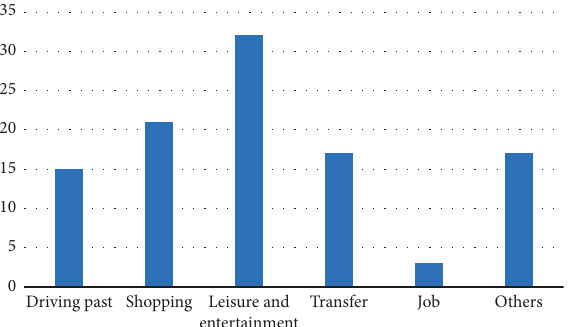
Figure 8: Thedistribution of thepurpose of the routeto Xudong area.